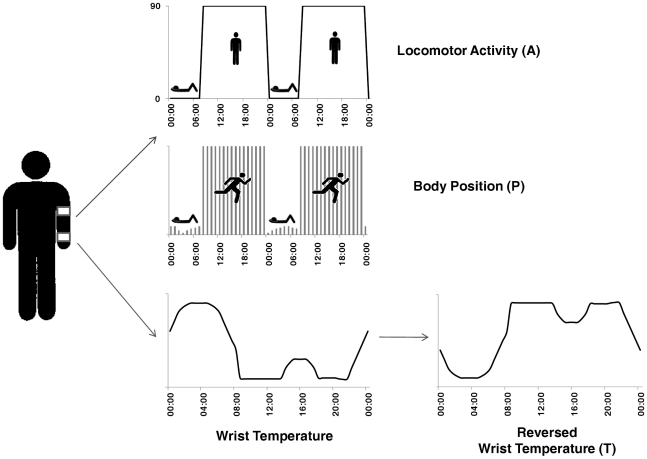
Body location of all sensors and simplistic representations of variables extracted.The activity data logger is placed in a sport band, on the upper non-dominant arm and the temperature data logger on the wrist of the non-dominant hand. Here it is shown the three variables selected for the study and a simplistic representation of their behaviour. Motor activity and body position show their higher levels during day-time, when the subject is active. Wrist temperature (T) profile, on the contrary, show its higher levels during the night, when the subject is resting. Then, to calculate TAP, we reversed T profile.